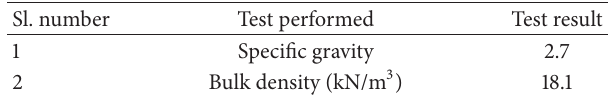
Table 3: Properties of stone dust.